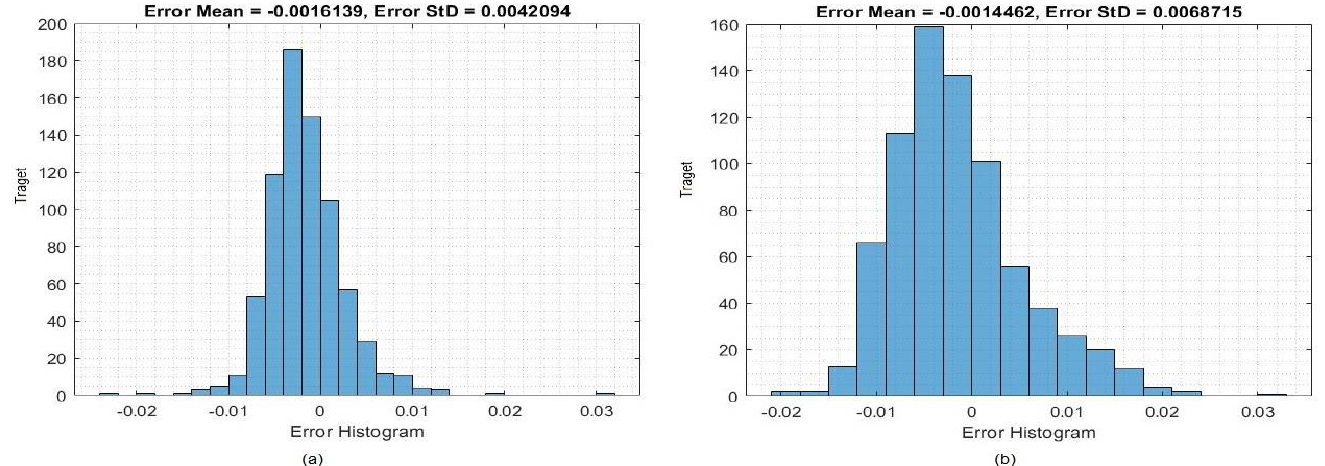
Figure 13. Histogram of the deep learning models ( a ) CNN-LSTM and ( b ) LSTM for predicting the Apple stock market closing price during the testing phase. Apple stock market closing price during the testing